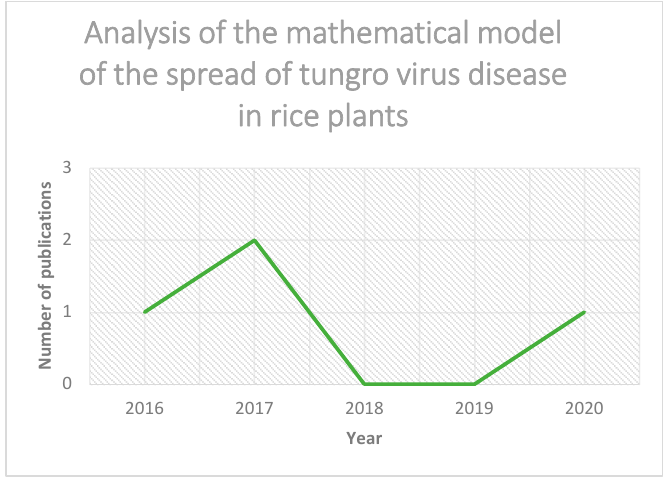
Figure 9. Data on publication of mathematical models of tungro disease.